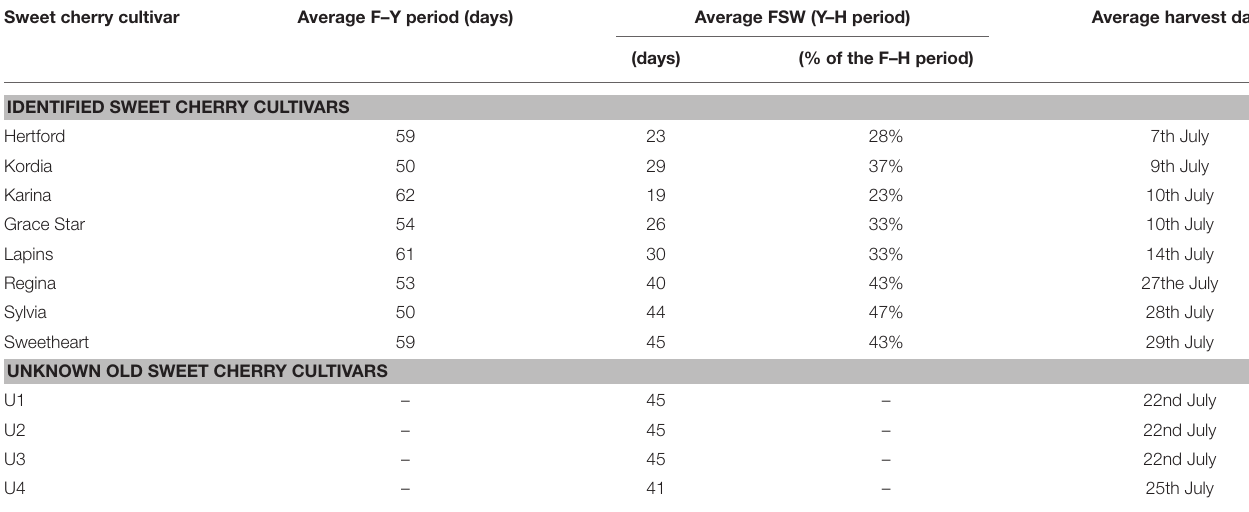
TABLE 2 | On-farm (PC-Fruit) recorded “Fruit suitability windows” for R. cerasi oviposition in various sweet cherry cultivars*. Sweet cherry